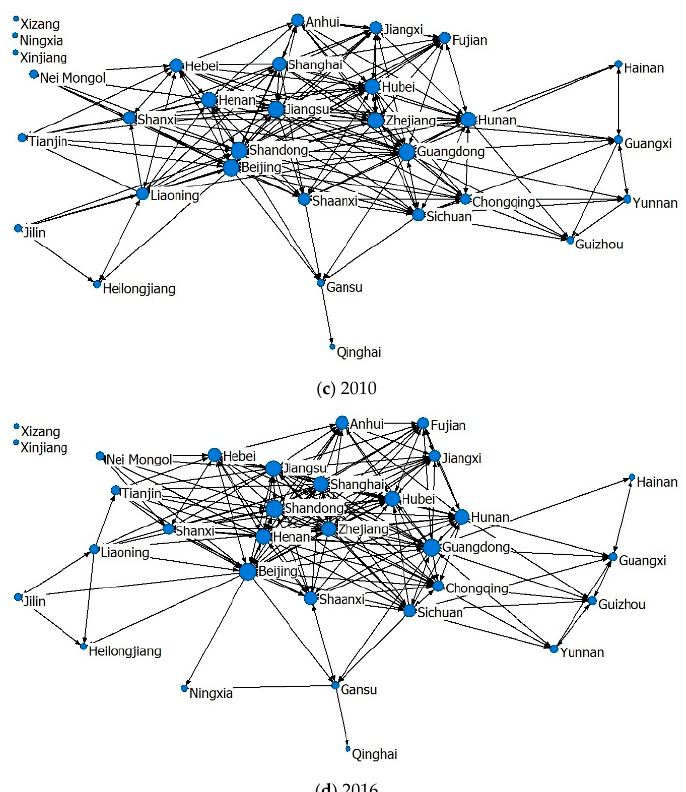
Figure 1. Spatial correlation network of tourism investment in China from 2000 to 2016 ( a – d ).